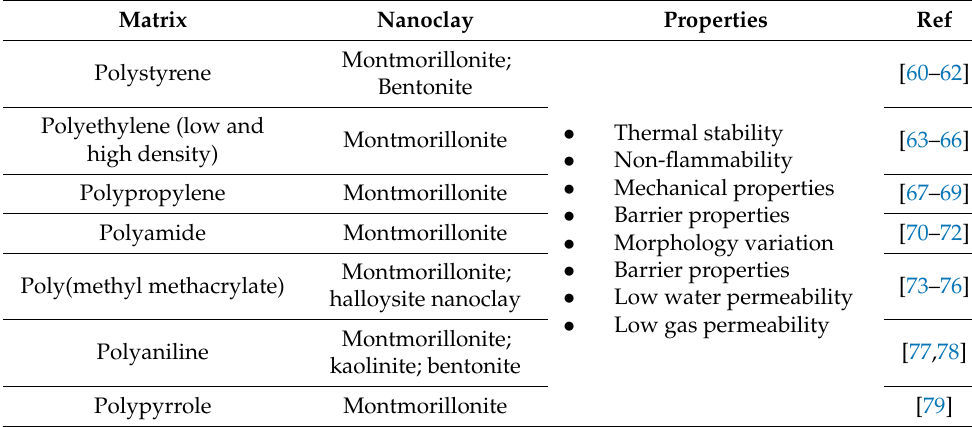
Table 3. Recent survey on synthetic polymer/clay